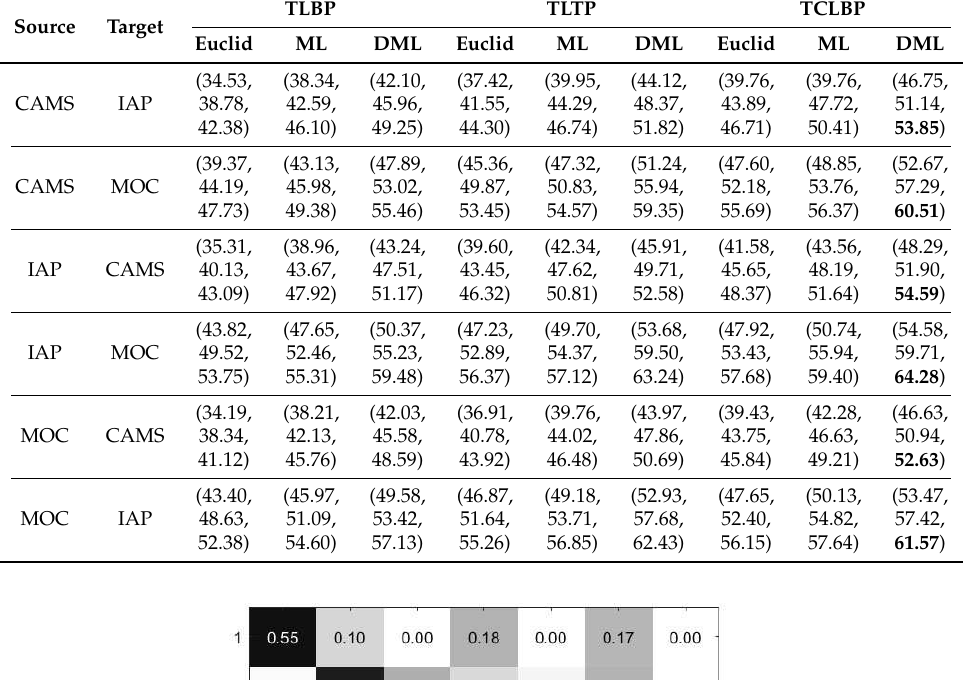
Table 5. Cross-domain classification accuracies (%) of transferred local features with different metrics. The three accuracy numbers in a triple are the basic classification accuracy, the recognition accuracy after IGC, and after FN, respectively.